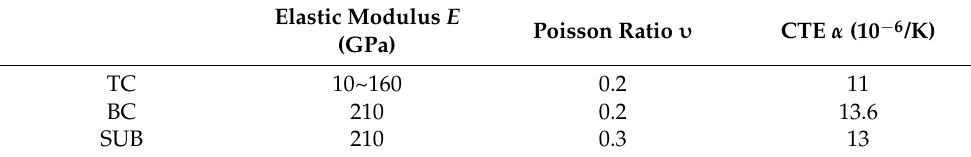
Table 2. Material properties of each